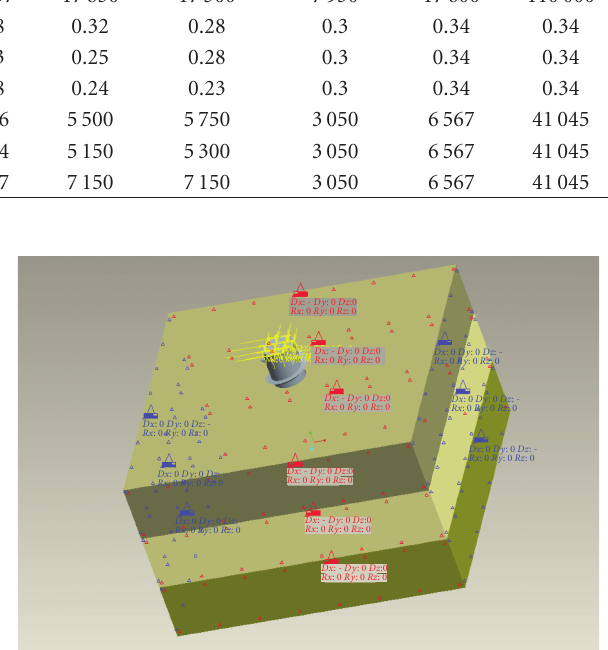
Figure 4: The 3D Pro/E assembly with boundary conditions. The bone layers are treated as orthotropic.